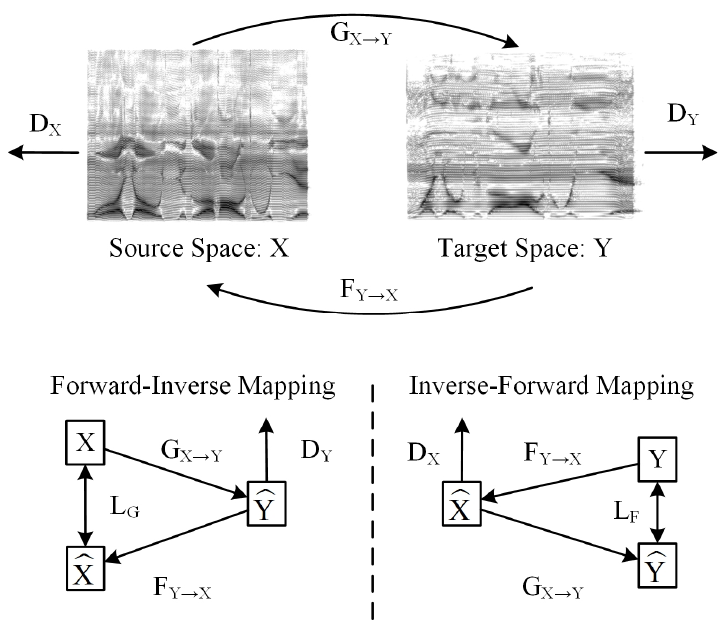
Figure 3 . The data flow between the source space and the target space of CycleGAN. Figure 3. The data flow between the source space and the target space of